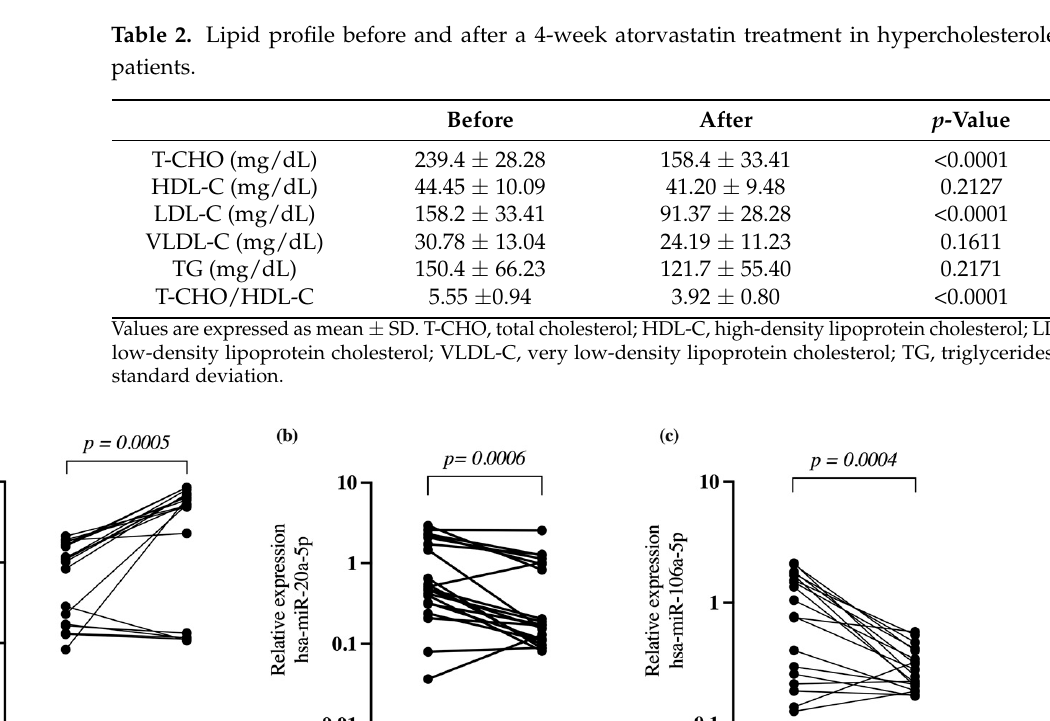
Figure 1. Relative expression of miRNAs in hypercholesteremic patients treated with atorvastatin. ( a ) hsa-miR-17-5p, ( b ) hsa-miR-20a-5p and ( c ) hsa-miR-106a-5p. The relative expression was deter- mined by RT-qPCR from enriched RNA extracted from leukocyte cells in the peripheral blood of hypercholesteremic patients before and after atorvastatin treatment (20 mg/day/4 weeks). Normal- ization was performed using hsa-miR-191 as a reference gene; p -value was obtained by paired t